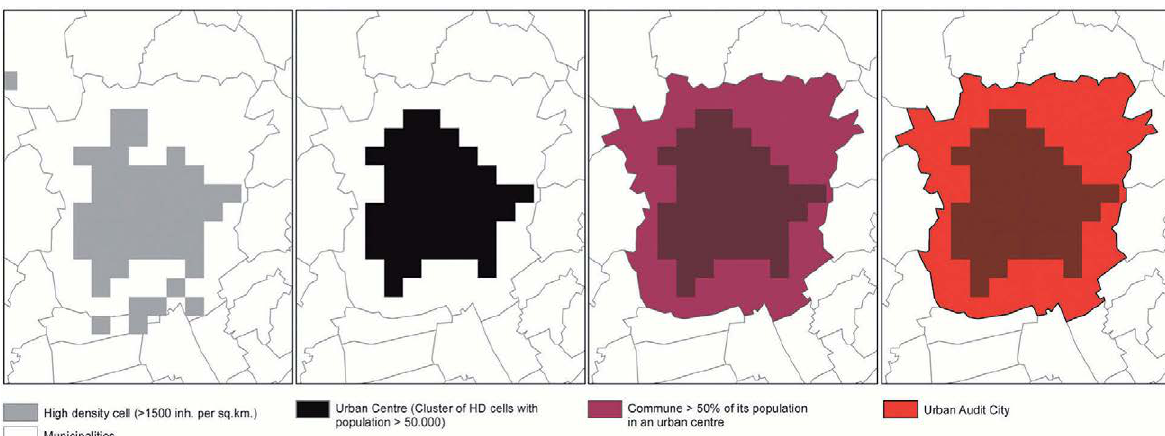
Fig. 3. Eurostat methodology for the delimitation of cities: high-density cells, urban centre, commune, and urban audit city (the city of Graz).